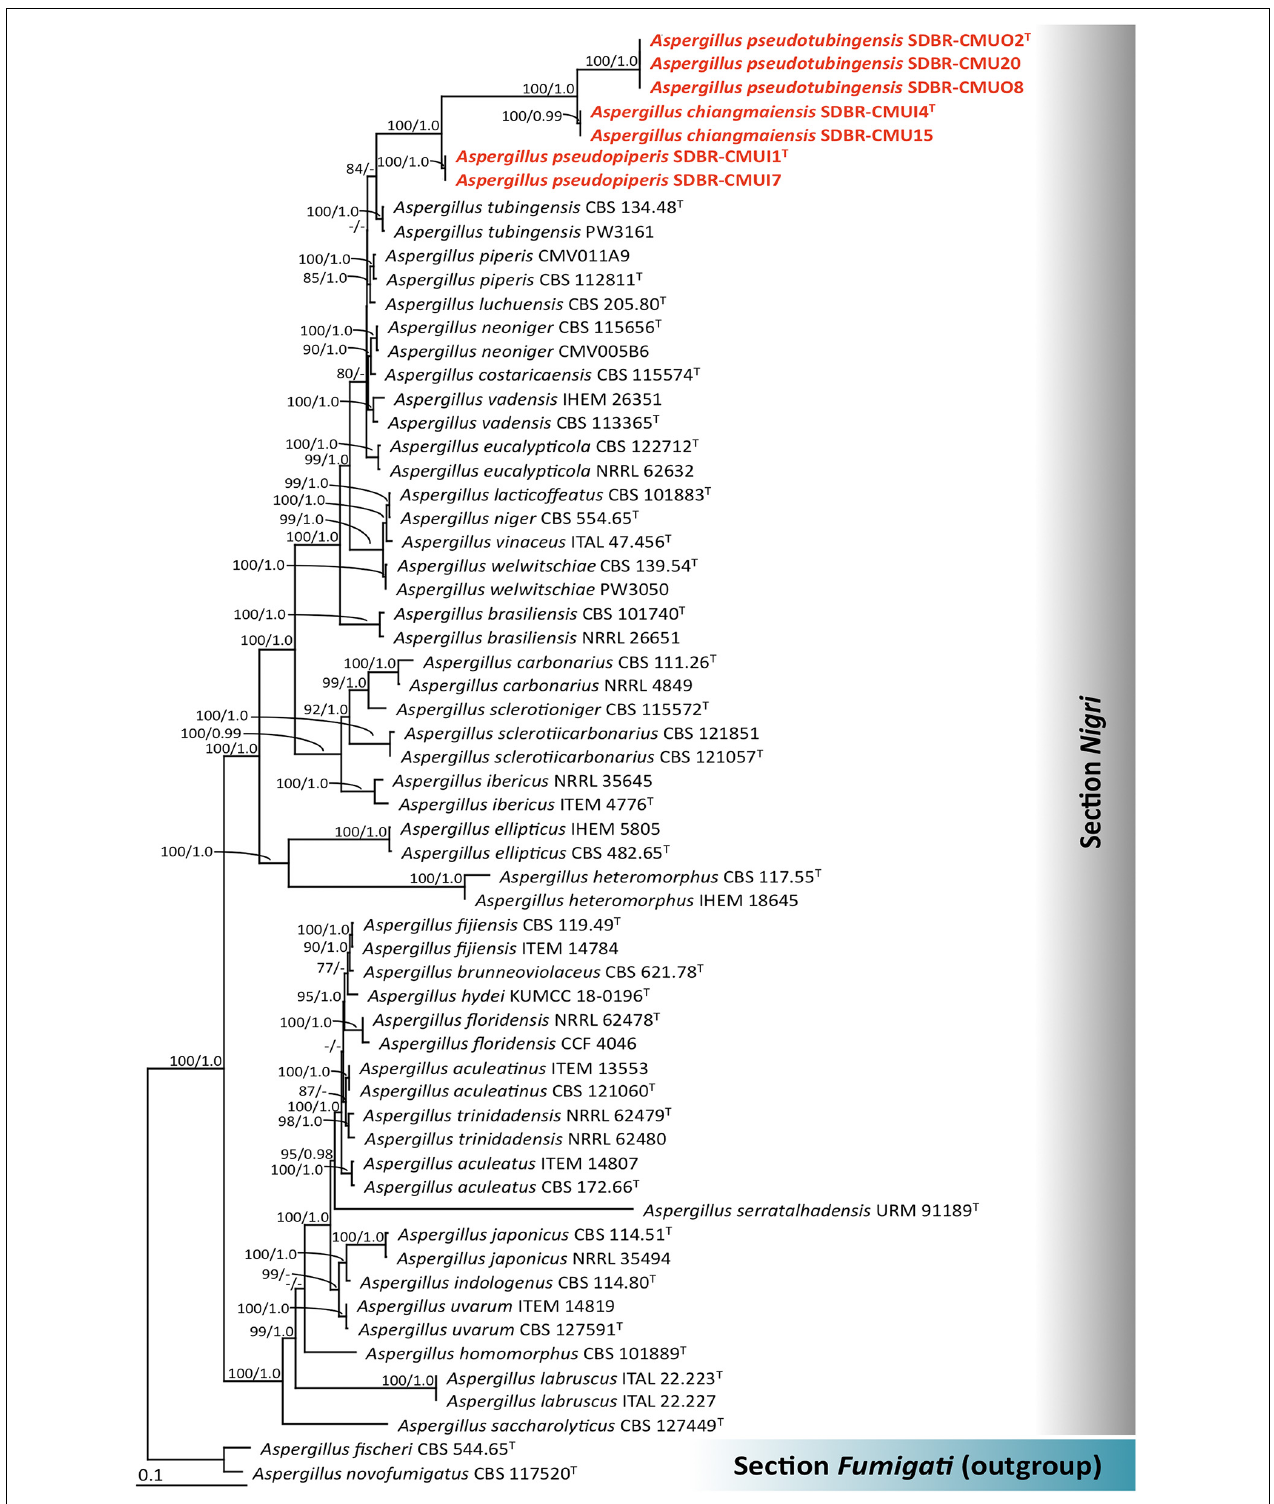
FIGURE 1 | Phylogenetic tree derived from maximum likelihood (ML) analysis of the combined cam , benA , rpb2 , tef1 , and act genes of 61 sequences. Aspergillus fischeri and Aspergillus novofumigatus were used as outgroup. Numbers above branches are bootstrap (BS) values (left) and posterior probability (PP) values (right). Branches with BS and PP values more than 70% and 0.95, respectively, are shown at each branch. Bar represents 0.1 substitutions per nucleotide position. Hyphen (-) represents support values ≤ 70%/0.95. Superscript “T” indicates the type species. The fungal strains obtained in this study are represented in bold red.